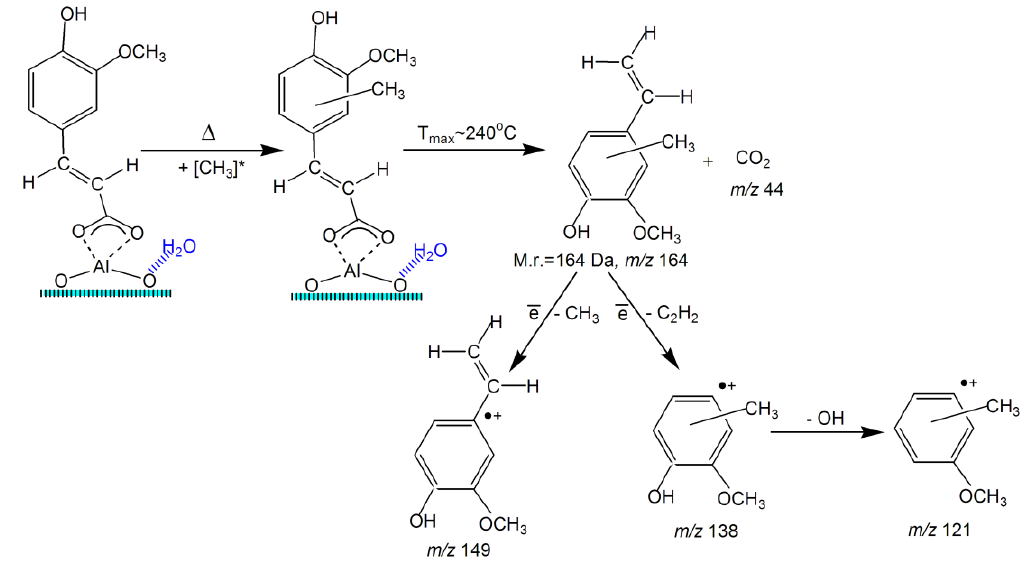
Scheme 3. The possible way of methylated 4-vinylguaiacol formation.